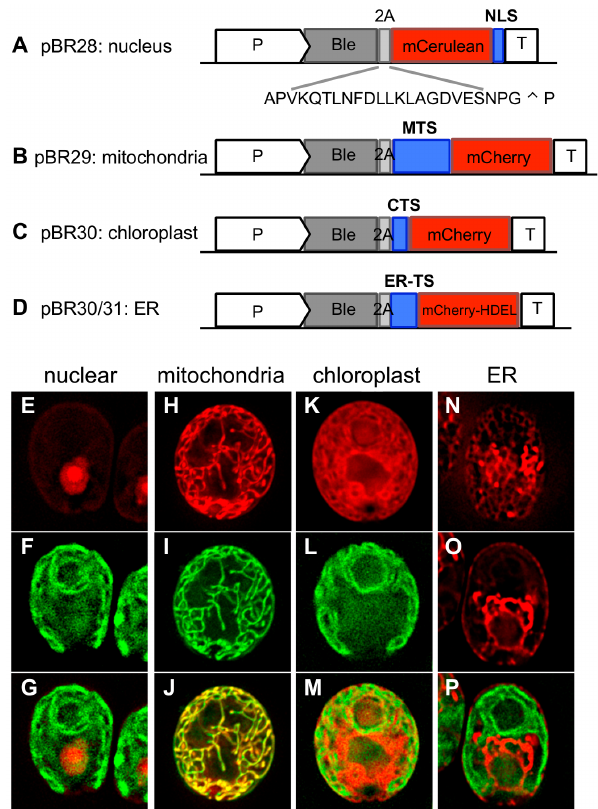
Figure 1. Chlamydomonas transformation vectors for protein targeting to specific subcellular locations. A–D. Schematic representation of Chlamydomonas targeting vectors. All transformation vectors contain the hsp70/rbcs2 promoter (P), the ble gene that confers resistance to zeocin, the 2A self-cleaving sequence from foot-and- mouth-disease virus, and the rbcs2 terminator (T). The site of cleavage is indicated with an arrowhead. A. pBR28, mCerulean is targeted to the nucleus by a C-terminal fusion to 2xSV40 NLS. B. pBR29, mCherry is targeted to the mitochondria by an N-terminal fusion to the mitochondrial transit sequence (MTS) of mitochondrial atpA. C. pBR32, mCherry is targeted to the chloroplast using the chloroplast transit sequence (CTS) from psaD. D. pBR30/31, mCherry is targeted to the ER using the ER-transit sequence (ER-TS) from either BiP1 or ars1. The ER retention sequence H-D-E-L is fused to the C-terminus of mCherry. E–P. Microscopy images of cells transformed with pBR28 (E– G), pBR29 (H–J), pBR32 (K–M), and pBR30 (N–P). Top row are live cell images of the fluorescent proteins targeted to the nucleus (E), mitochondria (H), chloroplast (K) or ER (N, O). (I) The cell is co-stained with the mitochondrial dye Mitotracker. (N) Cross section through the top of a cell expressing mCherry in the ER allows for the visualization of the cortical ER network. (O) Cross section through the middle of the same cell as in (N). The chloroplast membranes are visualized in (F), (L) and (P). Merged images are shown in the bottom row.